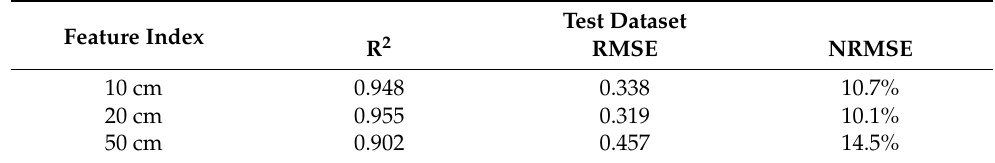
Table 8. Quantitative relationships between the LAI and measured values with different calculation grids based on the modified gap fraction model before and after canopy closure in the test dataset (experiments B and C) based on the maximum threshold modified porosity model.